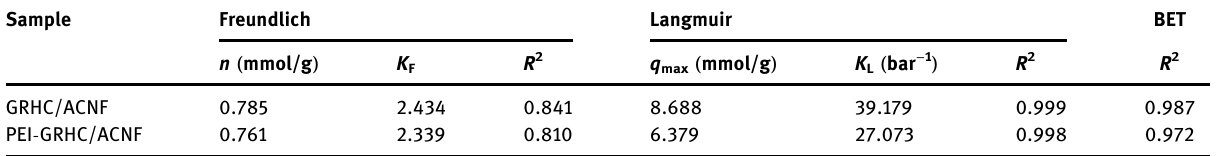
Table 10: The fi tted parameters of Langmuir, Freundlich, and BET isotherm models of PEI - GRHC/ACNFs and GRHC/ACNFs at 1 bar Sample